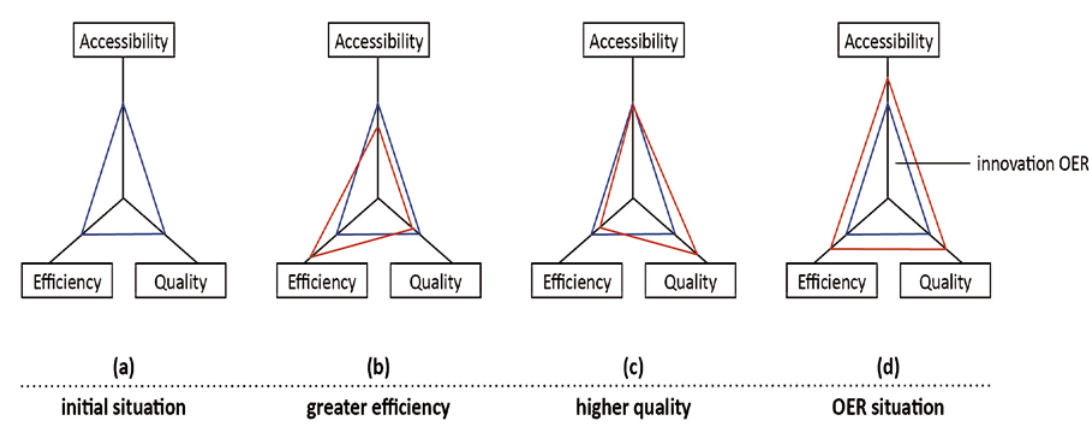
Figure 2 . Performance of Dutch education along the three axes accessibility, quality, and